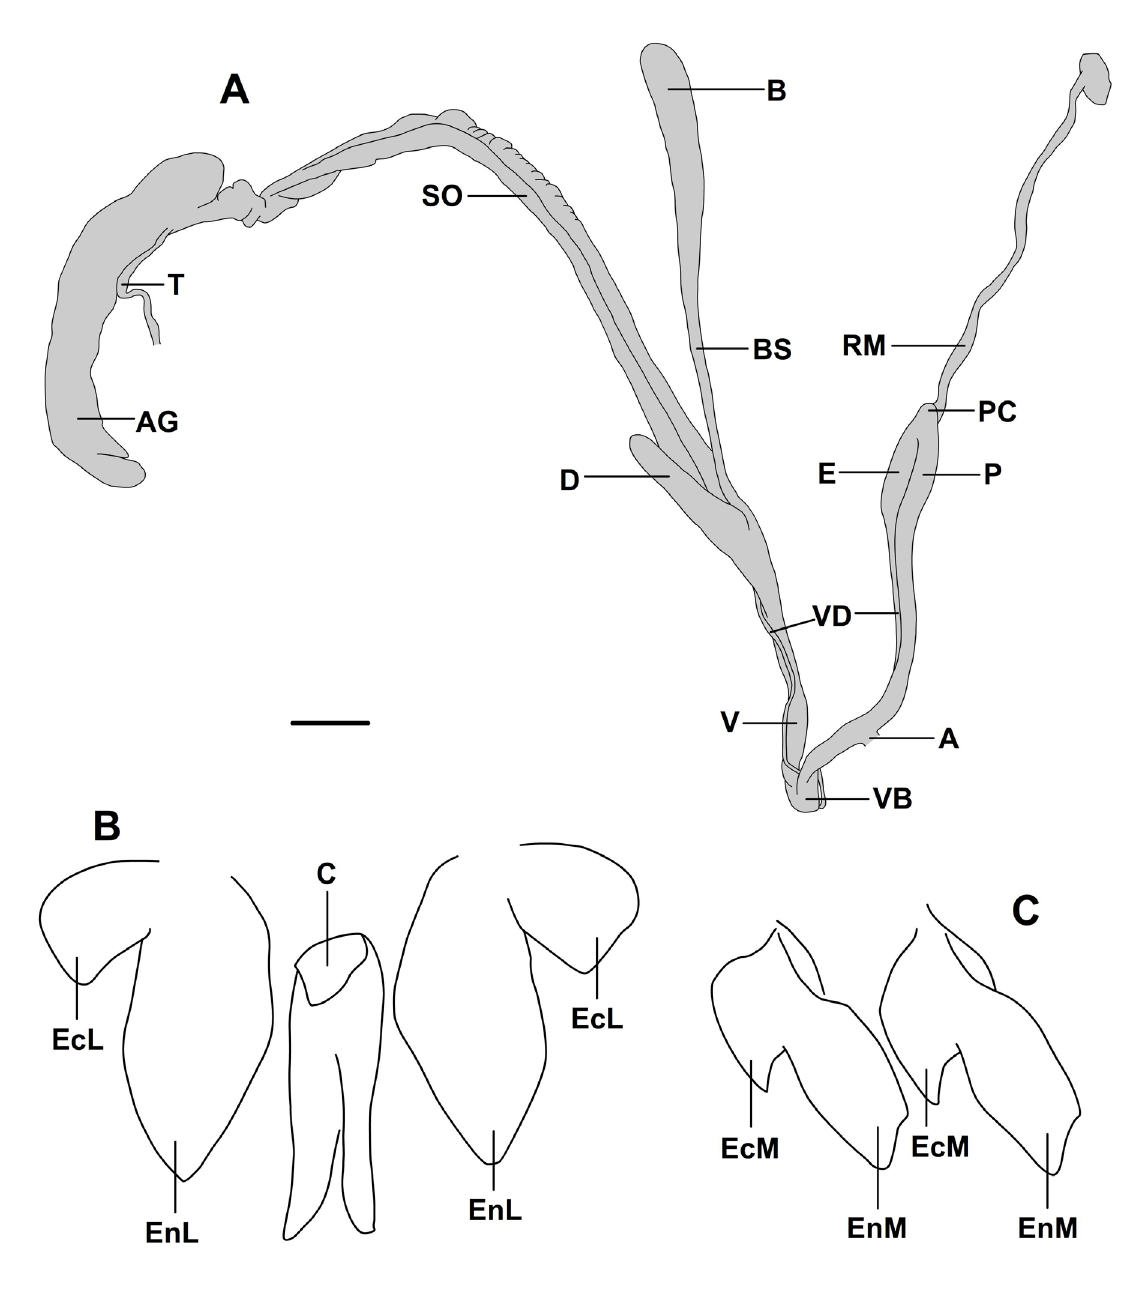
Fig. 2. A . Nomenclature of the genital system of the Plectopylinae ( Plectopylis bensoni Gude, 1914: 20091014A, OP7). B . Central and first lateral teeth. C . Marginal teeth. Abbreviations: A = atrium; AG = albumen gland; B = bursa of the bursa copulatrix; BS = stalk of the bursa copulatrix; C = central tooth; D = diverticulum; E = epiphallus; EcL = ectocone of a lateral tooth; EcM = ectocone of a marginal tooth; EnL = endocone of a lateral tooth; EnM = endocone of a marginal tooth divided slightly in the middle; P = penis; PC = penial caecum; RM = retractor muscle of the penis; SO = spermoviduct; T = talon; V = vagina; VB = vaginal bulb; VD = vas deferens. Scale bar: A = 2 mm; B–C not to